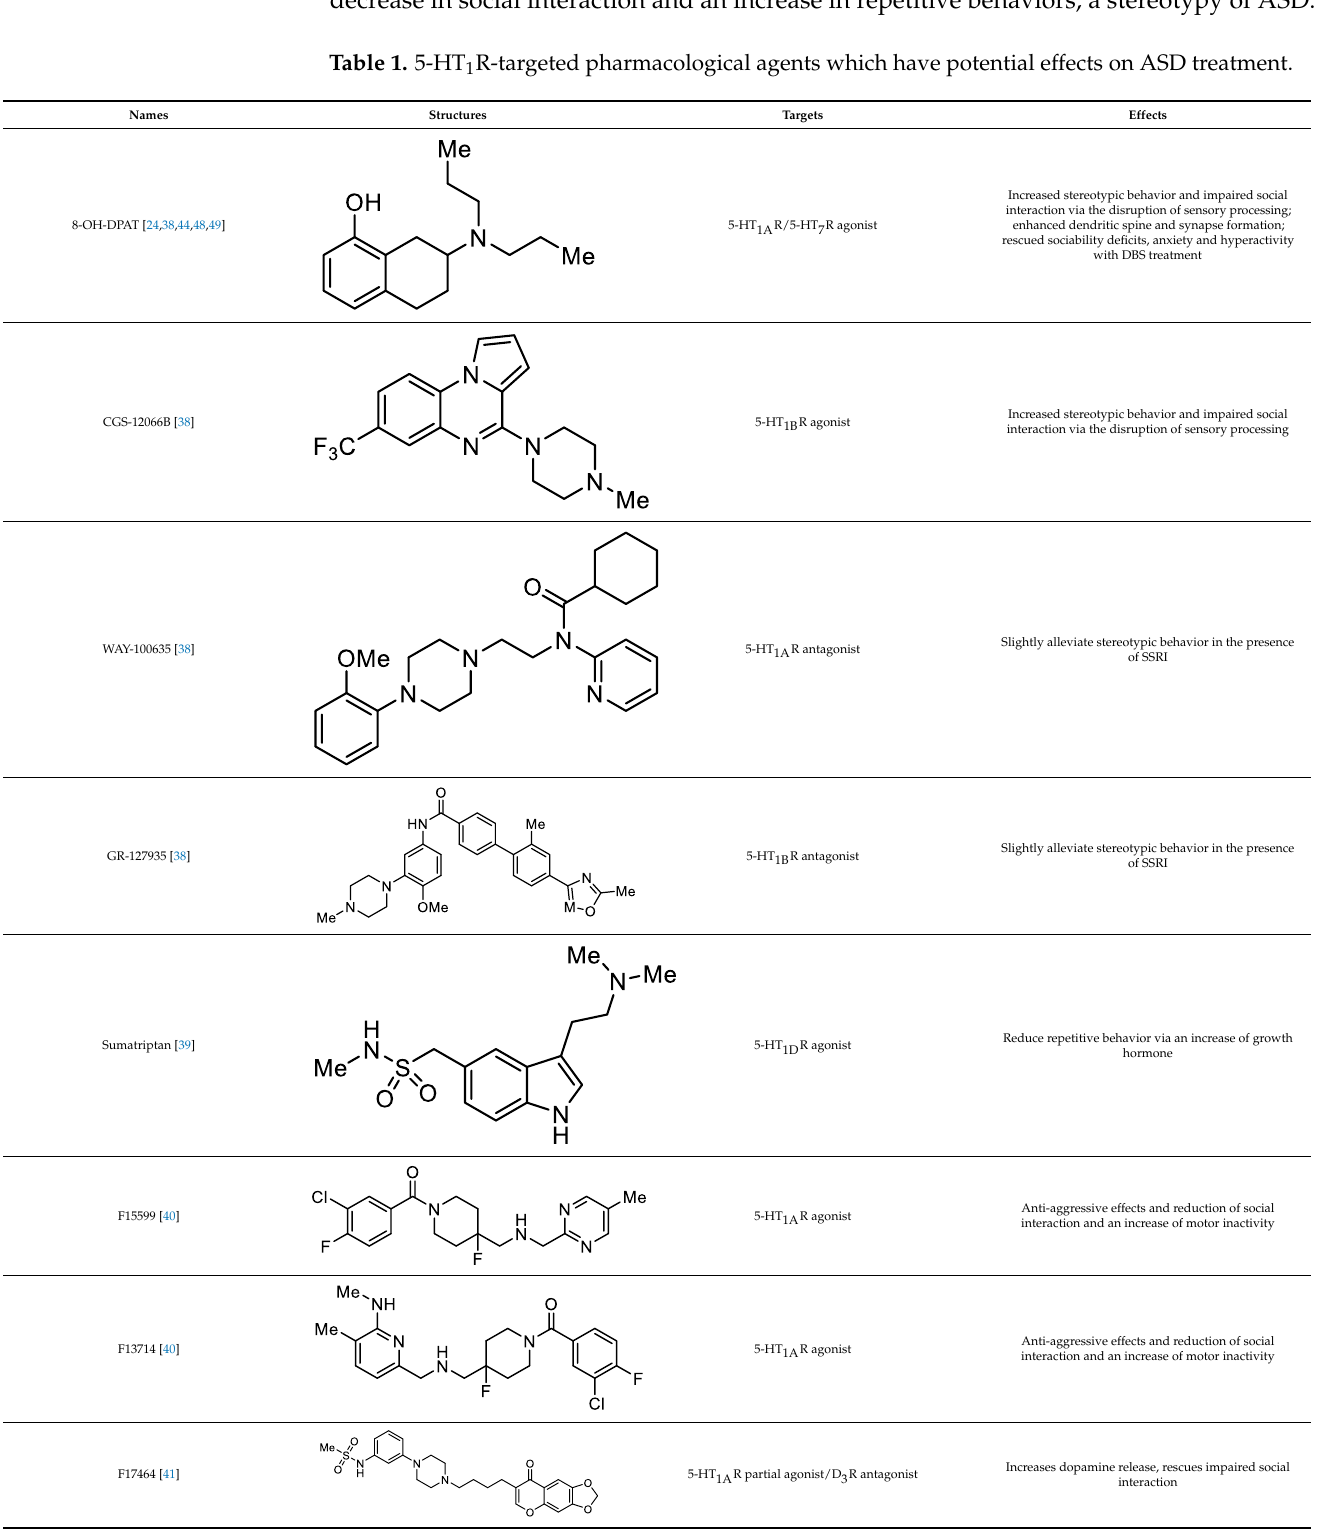
Table 1. 5-HT 1 R-targeted pharmacological agents which have potential effects on ASD treatment.